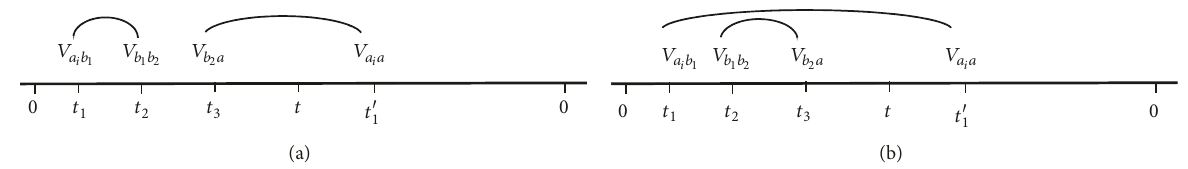
Figure 8: Two possible configurations for the pairing of matrix elements 𝑉 𝑎𝑏 that contribute to the second order of the survival probability ⟨𝑃 (2) (𝑡)⟩ 1󳨀→1